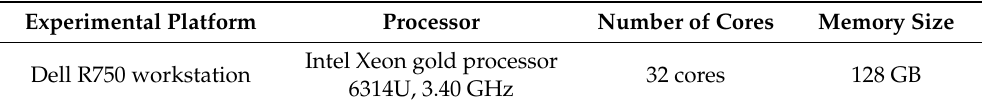
Table 3. The experimental platform used in the experiment.